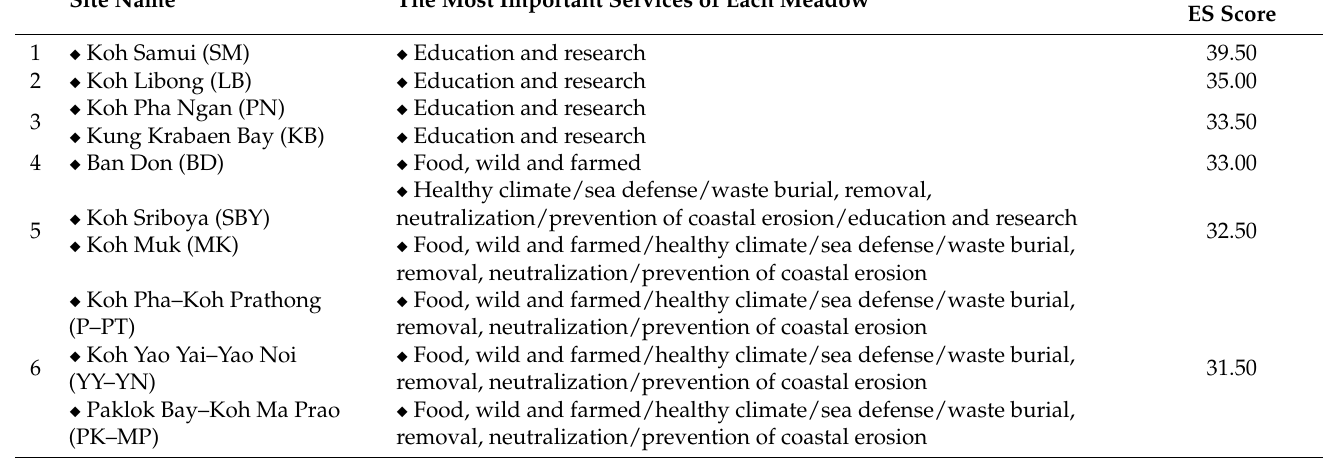
Table 1. Ten highest final ES scores (16 sites) from 82 seagrass sites across Thailand and the most important services of each site (1 = highest ES rank; 10 = 10th highest ES